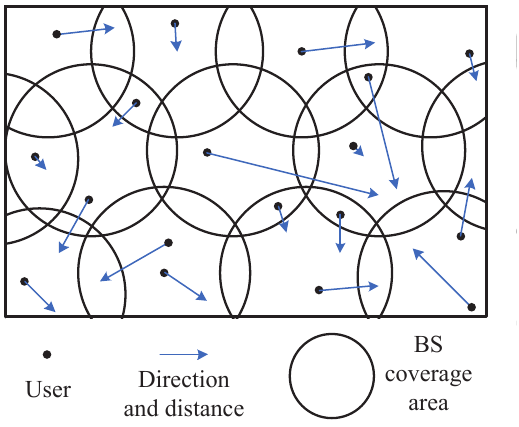
Figure 2. Mobility-Aware Edge Computing